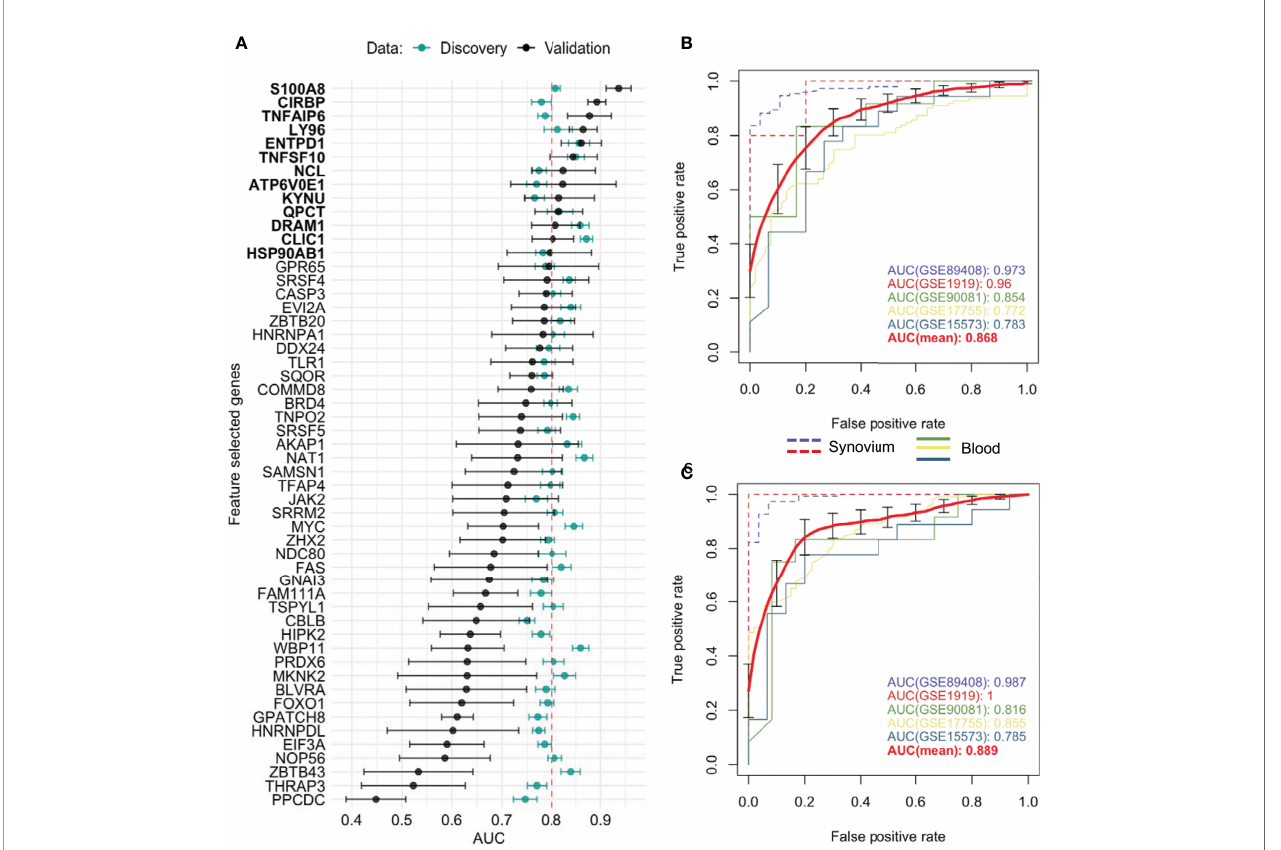
FIGURE 4 | Feature selected genes. (A) Mean AUC performance with standard error for each feature selected gene on testing synovium and blood datasets (green) and on fi ve independent validation datasets (black). 13 genes with AUC greater than 0.8 on validation datasets were chosen as the best performing genes. Mean AUC performance with standard errors of a RF model trained on discovery blood data with (B) common DE genes and (C) feature selected genes on fi ve independent validation datasets. The discovery-based classi fi ers were held fi xed and used once on each validation